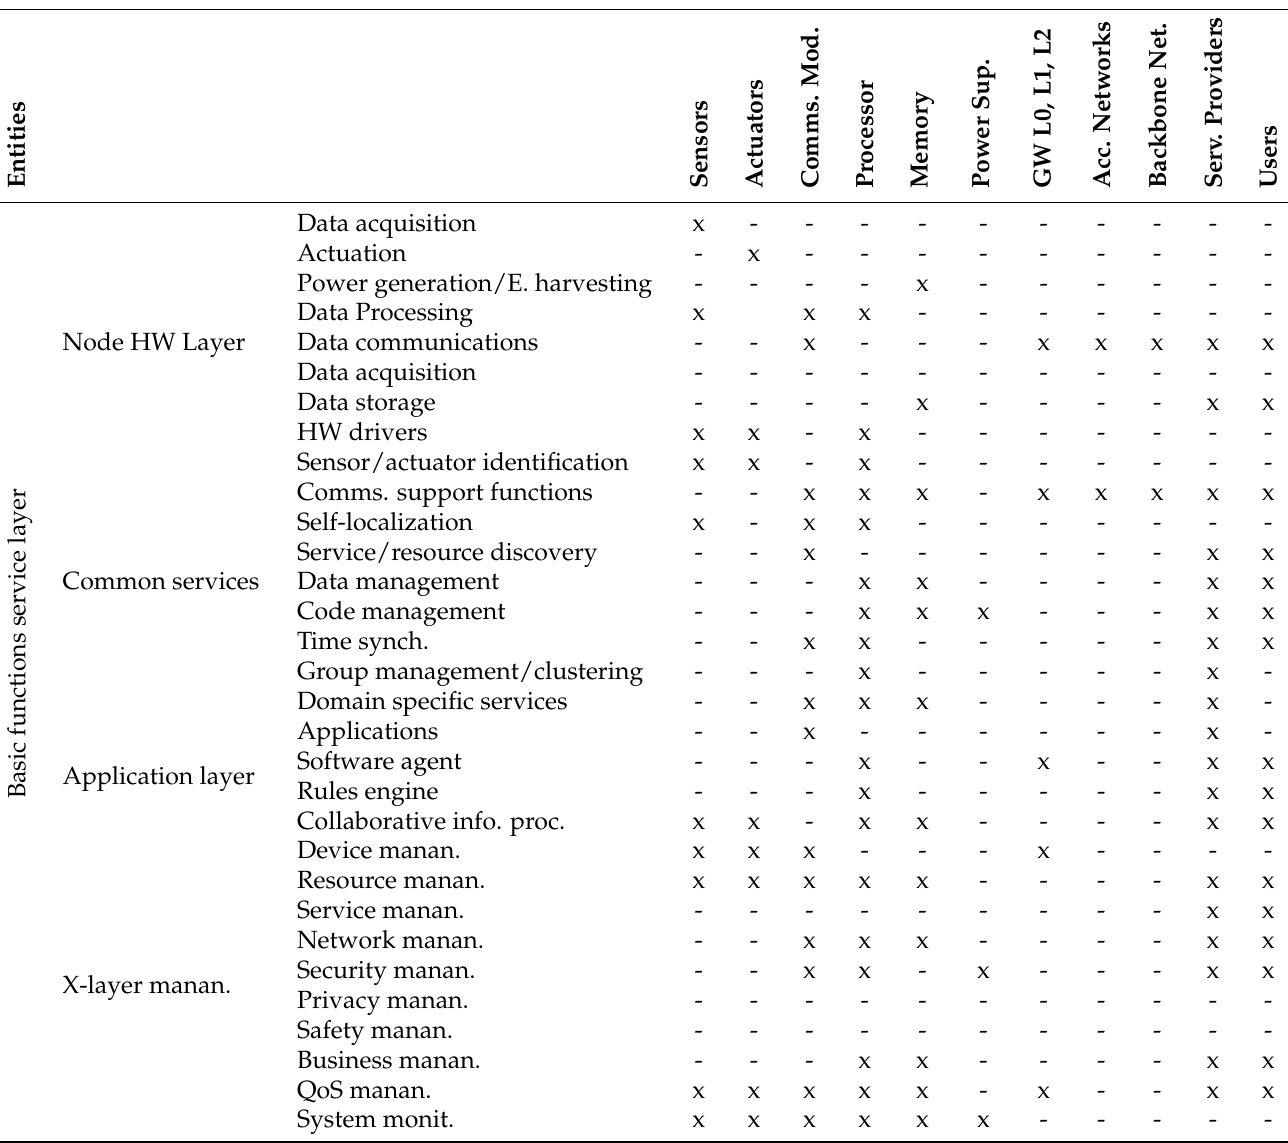
Table 9. DEWI HLA mapping to the ISO 29182 SNRA interface